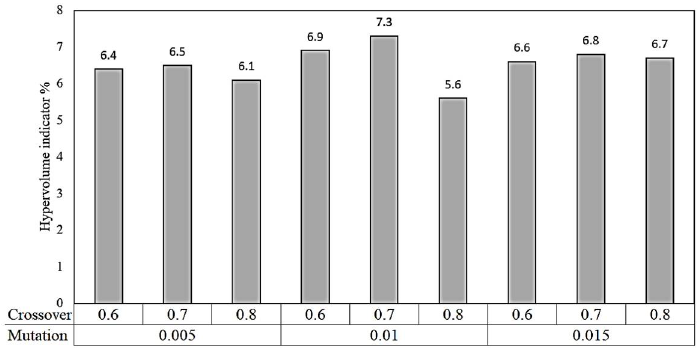
Figure 9. Hypervolume indicator for various values of mutation and crossover parameters.